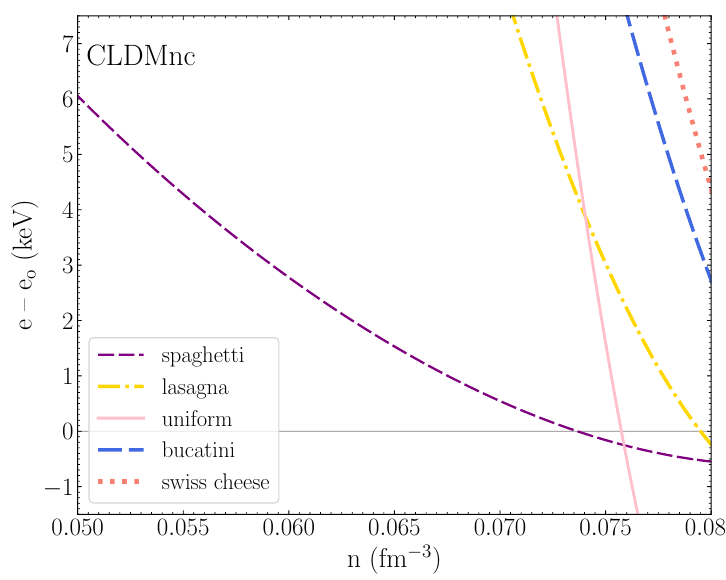
Figure 3. The same as Figure 2 but for